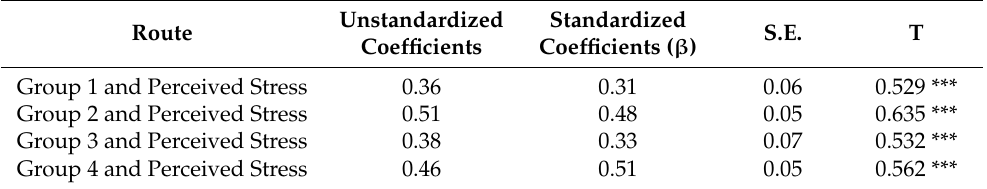
Table 10. The main result of the research